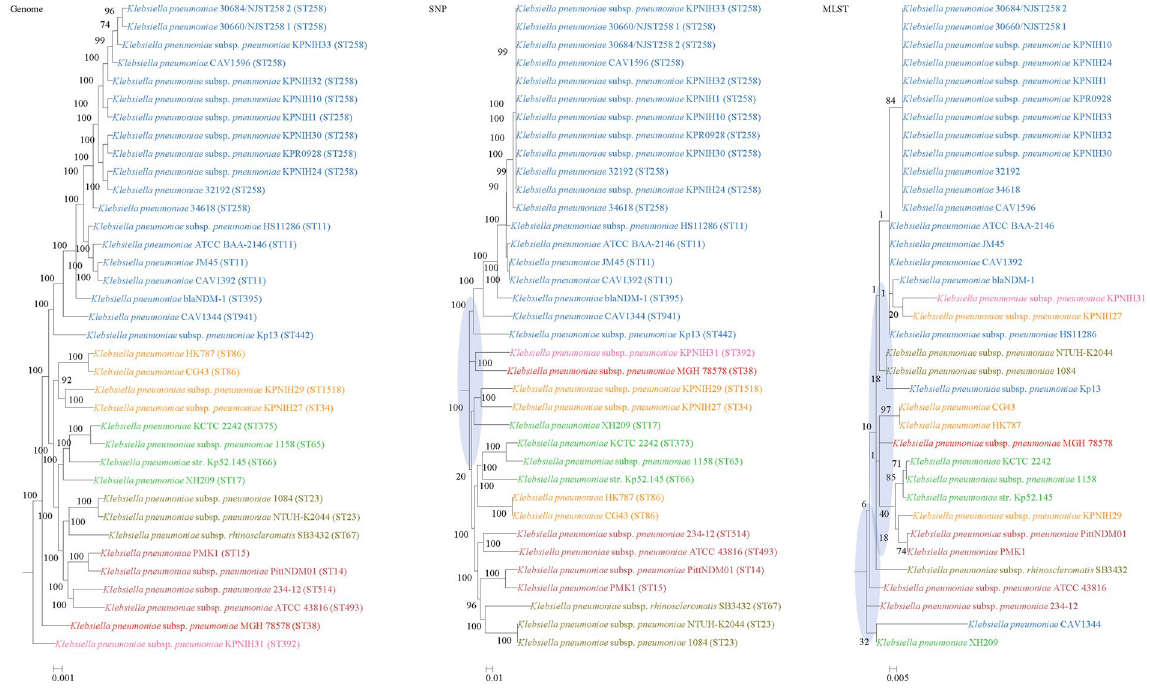
Figure 6. Comparison of phylogenetic trees constructed using genome data (left), SNP data (middle), and MLST data (right) for Klebsiella pneumoniae . Clusters that were manually selected based on the genome trees are illustrated in different colors. The unresolved polytomies are shaded in blue.